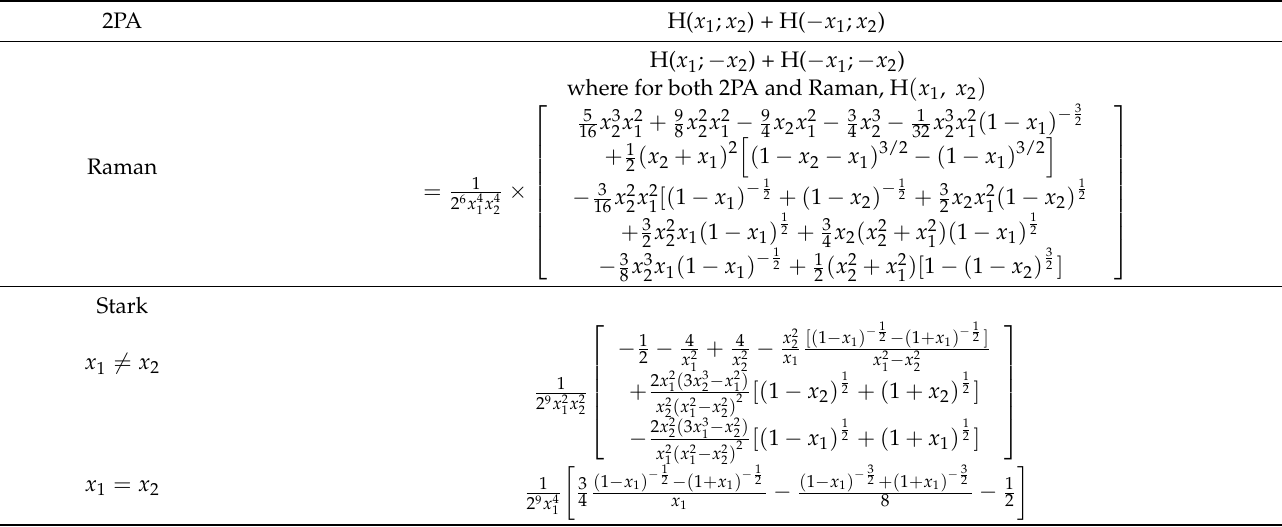
Table 3. Nondegenerate dispersion function G 2 for two-photon absorption (2PA), Raman, and optical Stark effects calculated by a Kramers–Krönig transformation of F 2